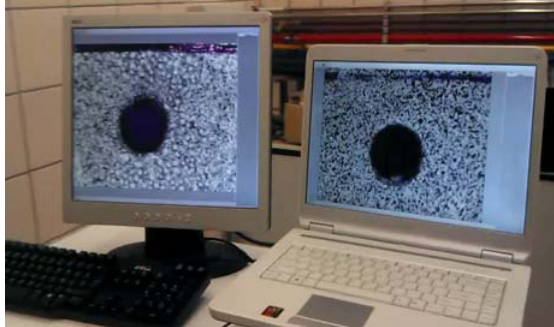
Figure 6: View of the notch during the test as acquired with the microscopes.